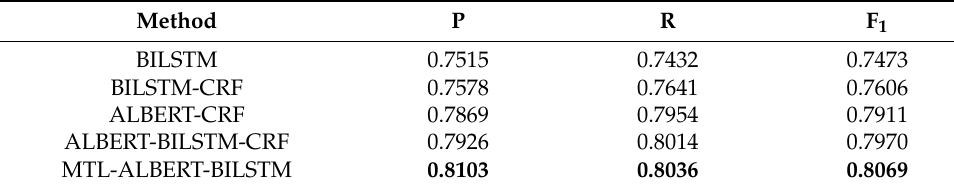
Table 2. Results of NER on different